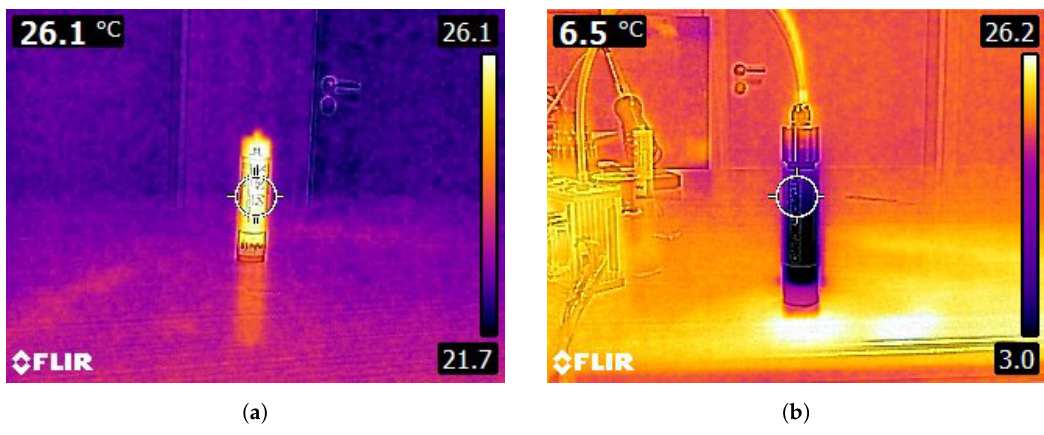
Figure 9. ( a ) Temperature of fuel stick before connecting to the fuel cell stack.; ( b ) temperature of fuel stick after connection to the fuel cell stack for an extended period ( ∼ 20 min), with an initial sudden release of hydrogen from the fuel stick. Fuel stick temperature drop test 2—captured by thermal imaging device